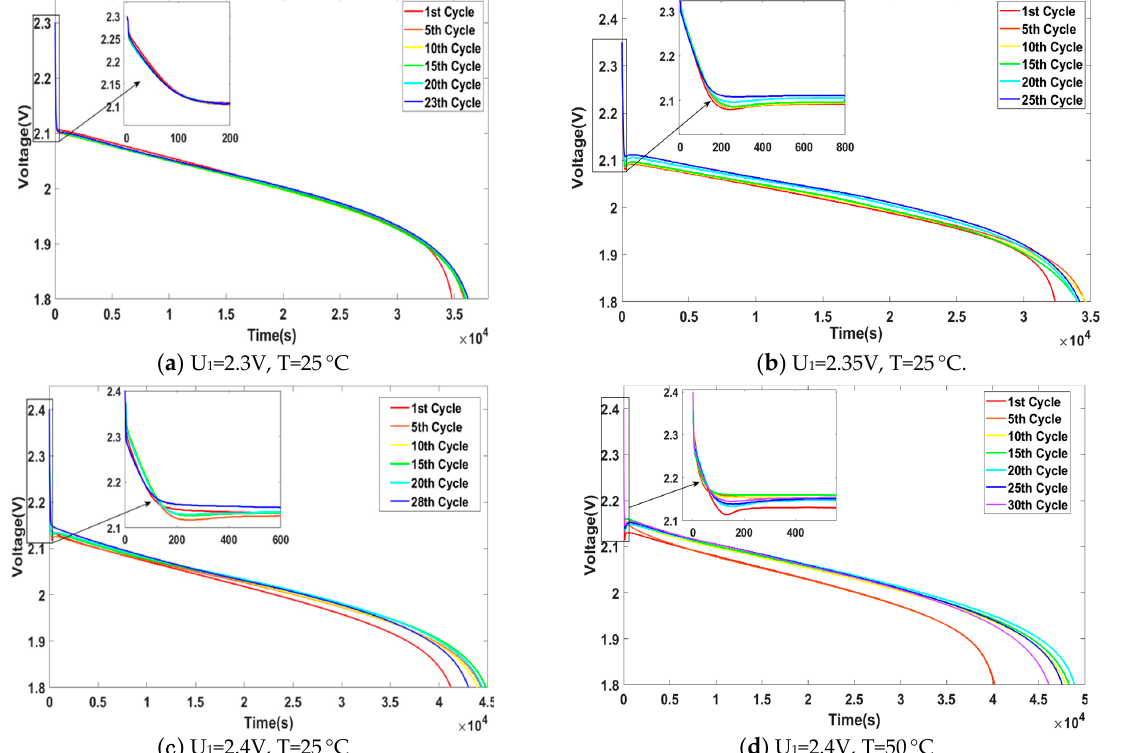
Figure 4. The discharge voltage curve of the battery under various working conditions and different cycle times.